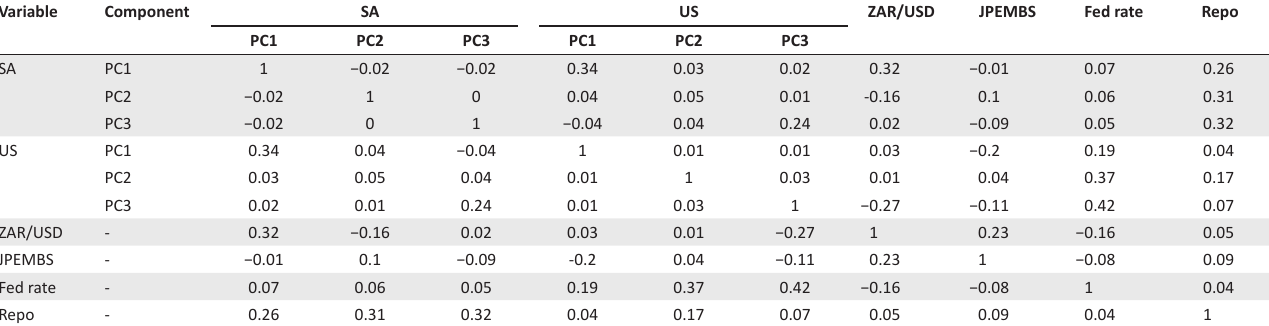
TABLE 1: Correlation results for period between 2000 and 2013. Variable Component